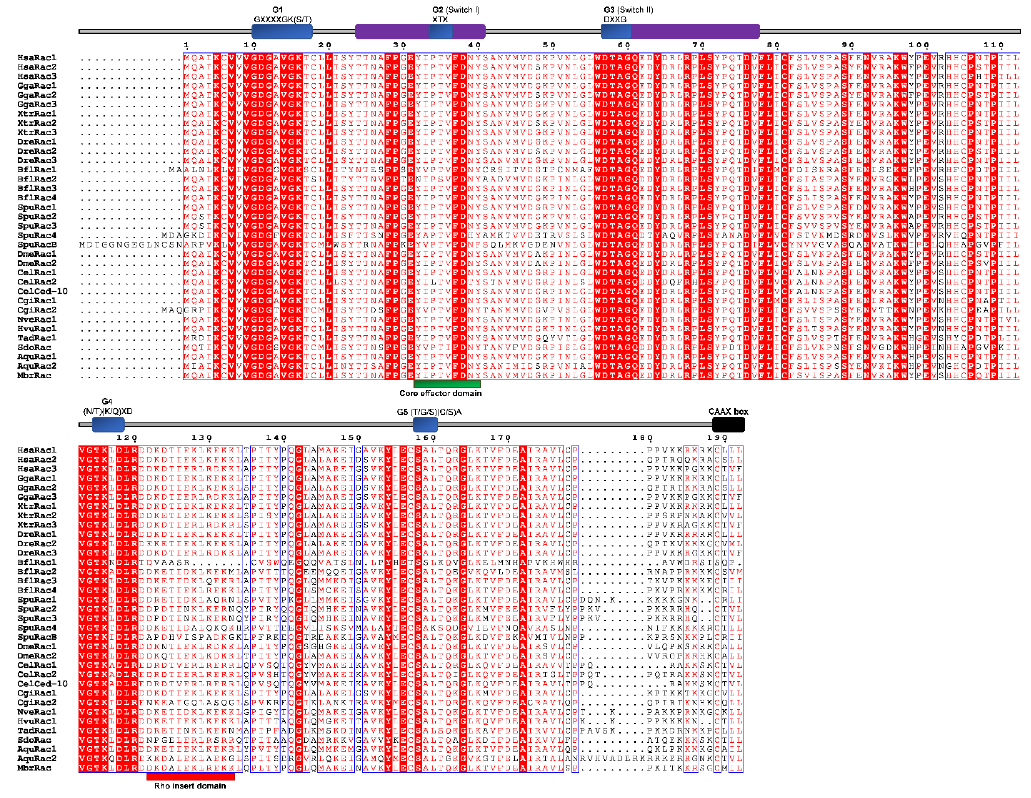
Figure 7. Sequence alignment of the Rac subfamily. The amino acid sequences of Rac GTPases were aligned using ClustalX, the secondary structures predicted using ESPript. Regions of the Rac proteins are indicated above the alignment; blue are the G domains, (G1, G2, G3, G4, and G5 with their respected motifs), purple are switch 1 and switch 2 domains, red is the Rho insert, green is the polybasic region, and black is the CAAX box. Blue frames are indicators of the conserved residues; white letters in red boxes represent identity, red letters in white boxes represent similarity.